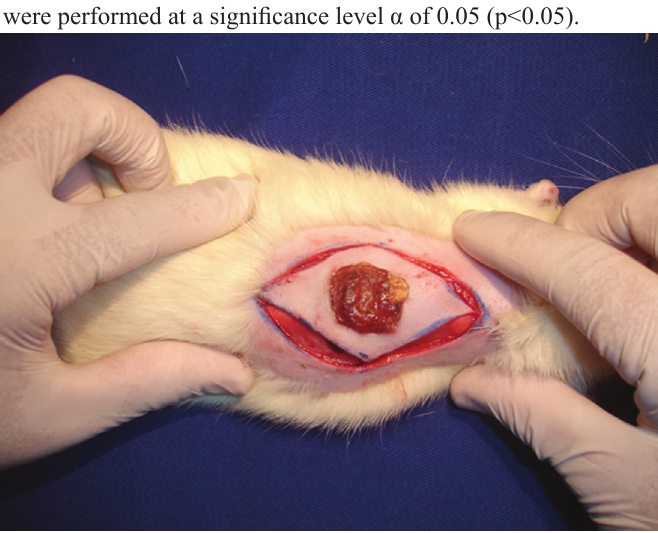
FIGuRE 1 – Removal of tissue for histomorphometric analysis.